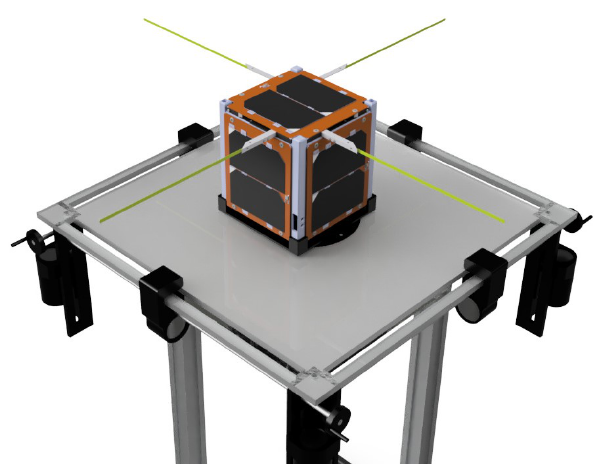
Figure 9. CubeSat air-bearing simulator CAD view with the